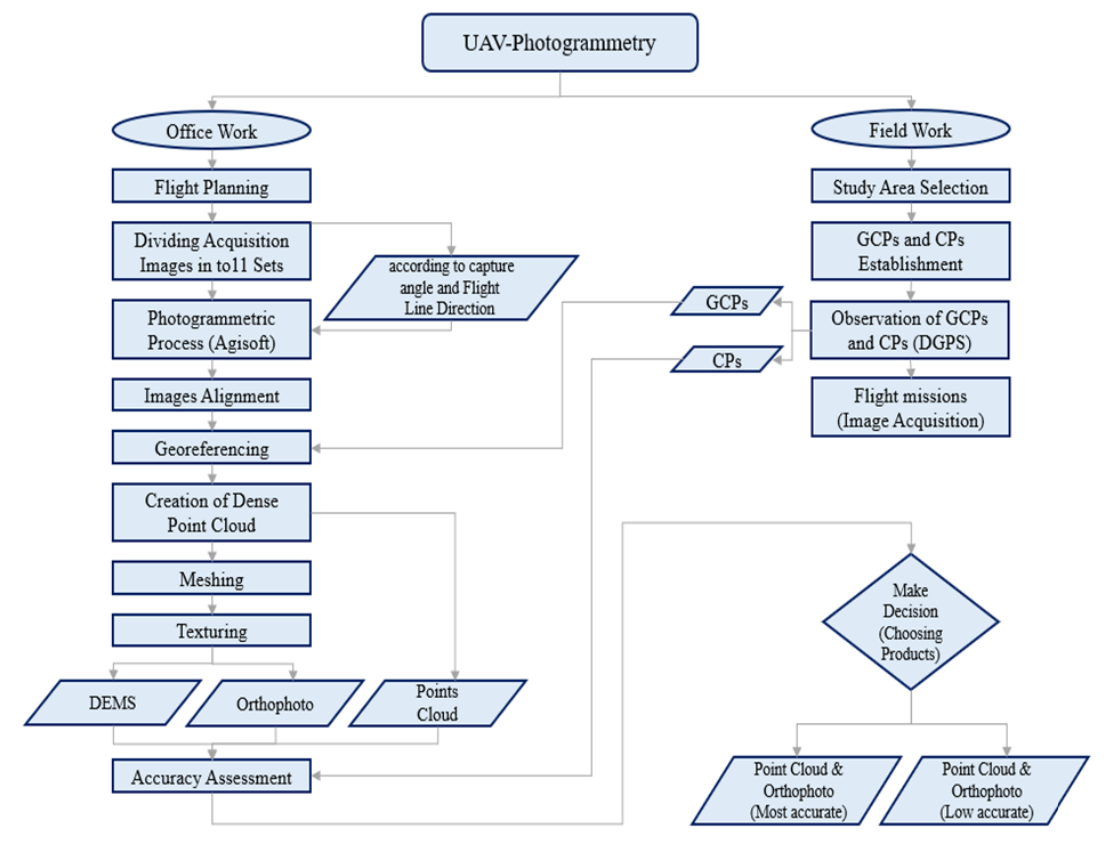
Figure 1. Workflow diagram of the methodology adopted in this paper.